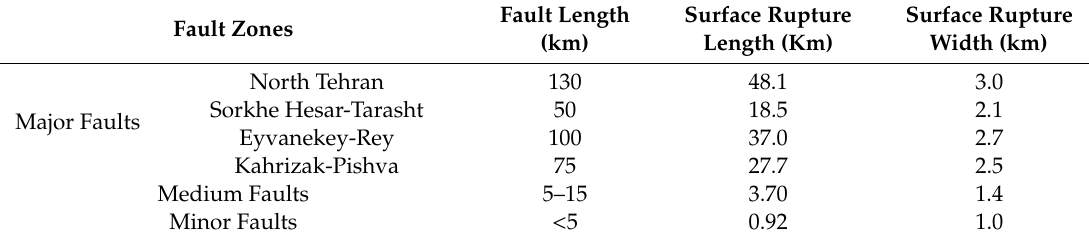
Figure 6. Surface rupture widths in the city of Tehran. Table 2. Surface rupture width of faults within